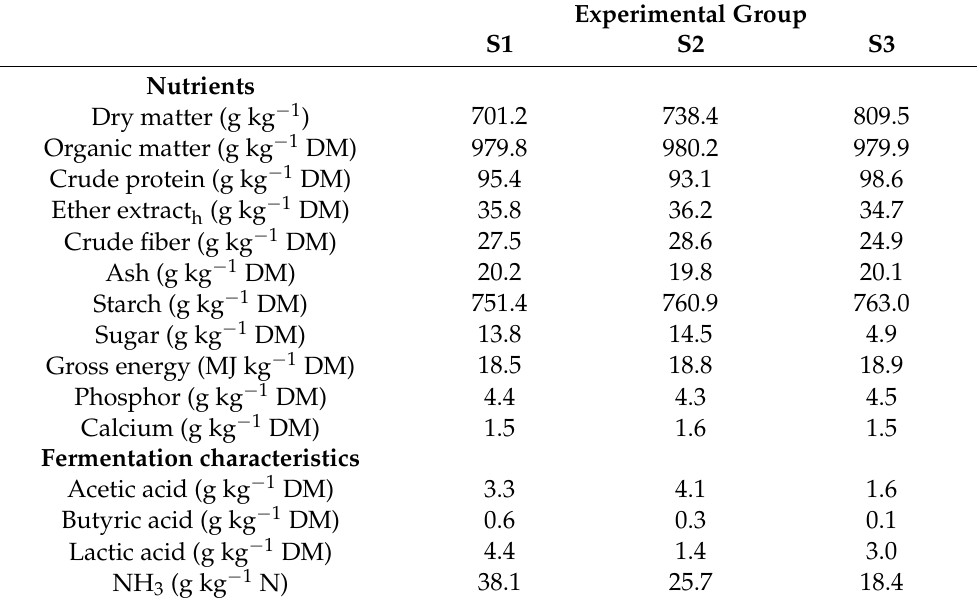
Table 2. Analyzed nutrient composition and fermentation characteristics of different whole grain sorghum conserves stored under anaerobic conditions for 6 months.